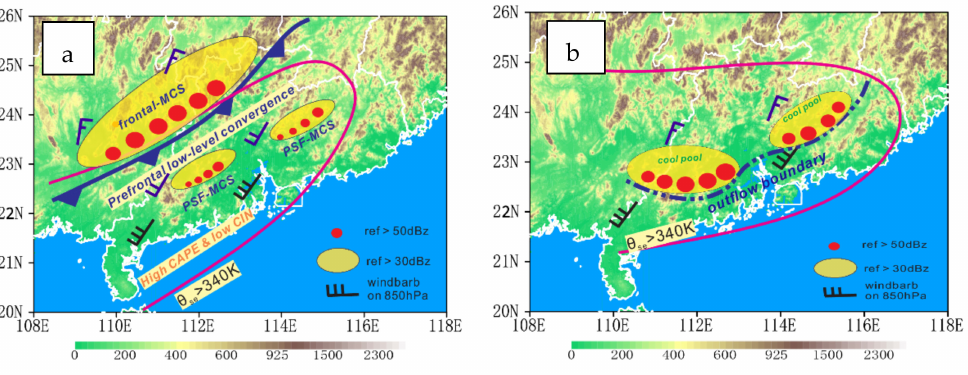
Figure 16. A conceptual model for a typical PSF-type WSHR event with the development of TL/AS MCSs, ( a ) T = T 0 , ( b ) T = T 0 + 6